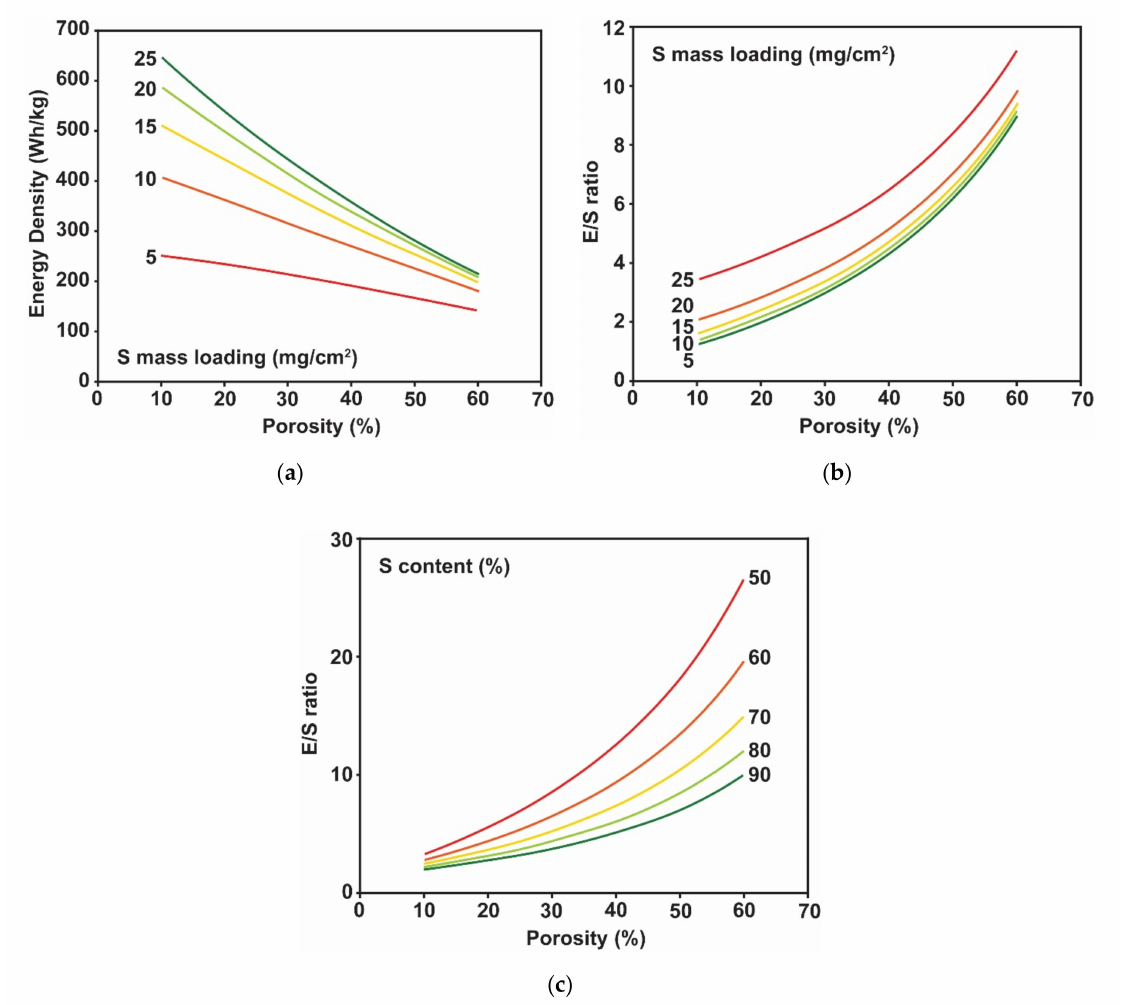
Figure 5. Design calculation results ( a ) Obtainable specific energy of a Li/S pouch cell for various porosity of sulfur electrode and sulfur mass loading. Sulfur content and sulfur utilization were assumed as 90% and 70%, respectively. ( b ) Variation in the E/S ratio depending on the sulfur electrode porosity and sulfur mass loading. The required electrolyte amount corresponds to the pore volume of the sulfur electrode and separator. The sulfur content was assumed as 90%. ( c ) Variation in the E/S ratio depending on the sulfur electrode porosity and sulfur content. Sulfur mass loading used for the calculation was 10 mg cm − 2